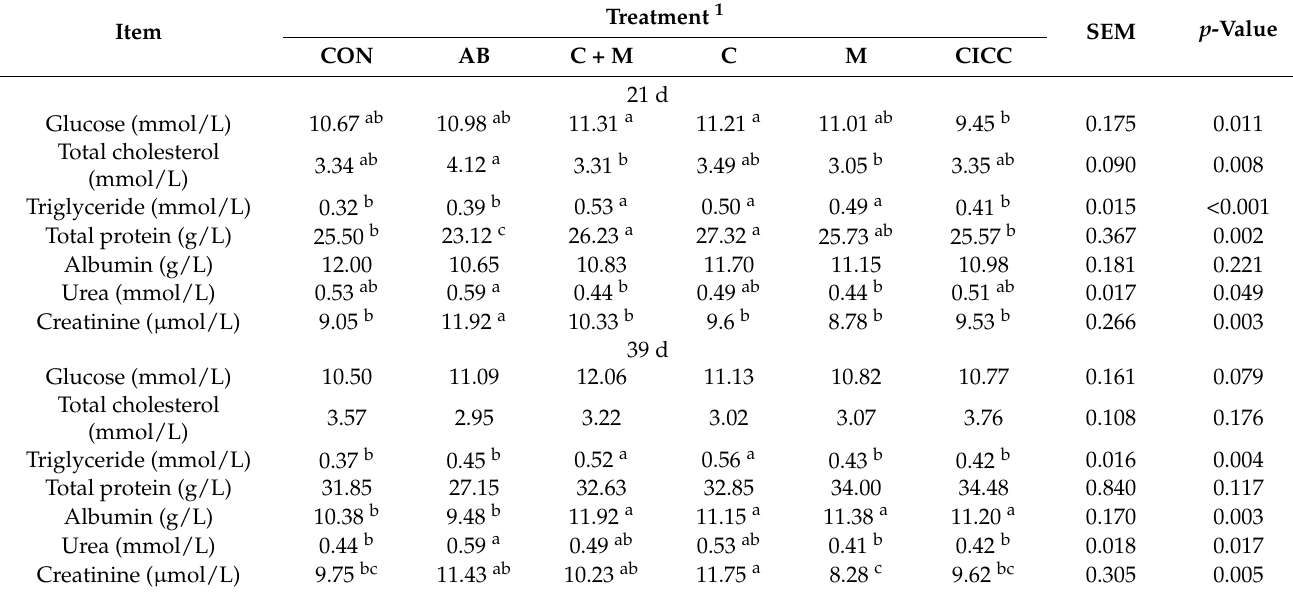
Table 3. Effect of Bacillus amyloliquefaciens LFB112 on serum biochemical indices of